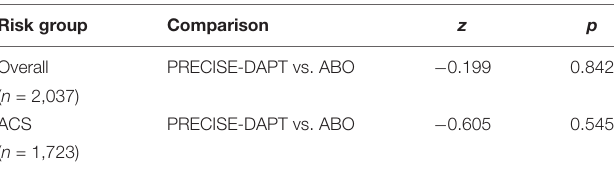
TABLE 3 | Comparisons of the discriminative power of the two risk scores for predicting BARC ≥ 2 bleeding. Risk group